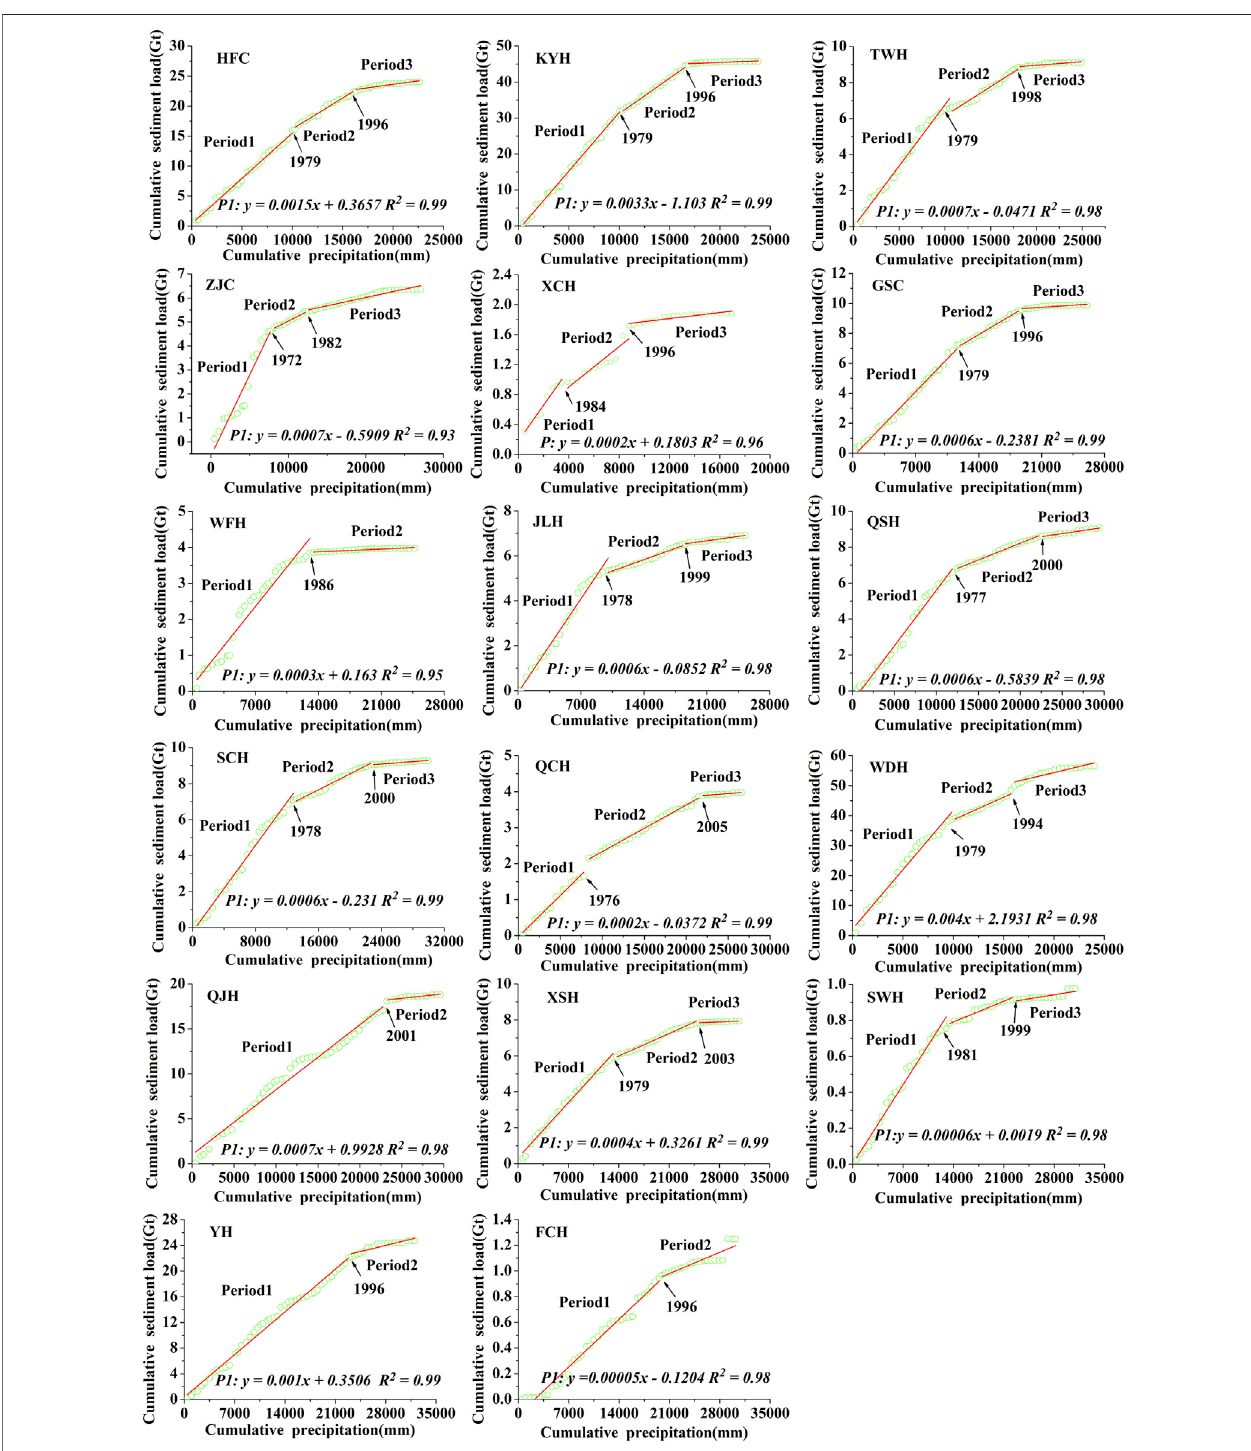
FIGURE 5 | Double mass curves of precipitation and sediment load in tributaries in the Hekou-Longmen region.